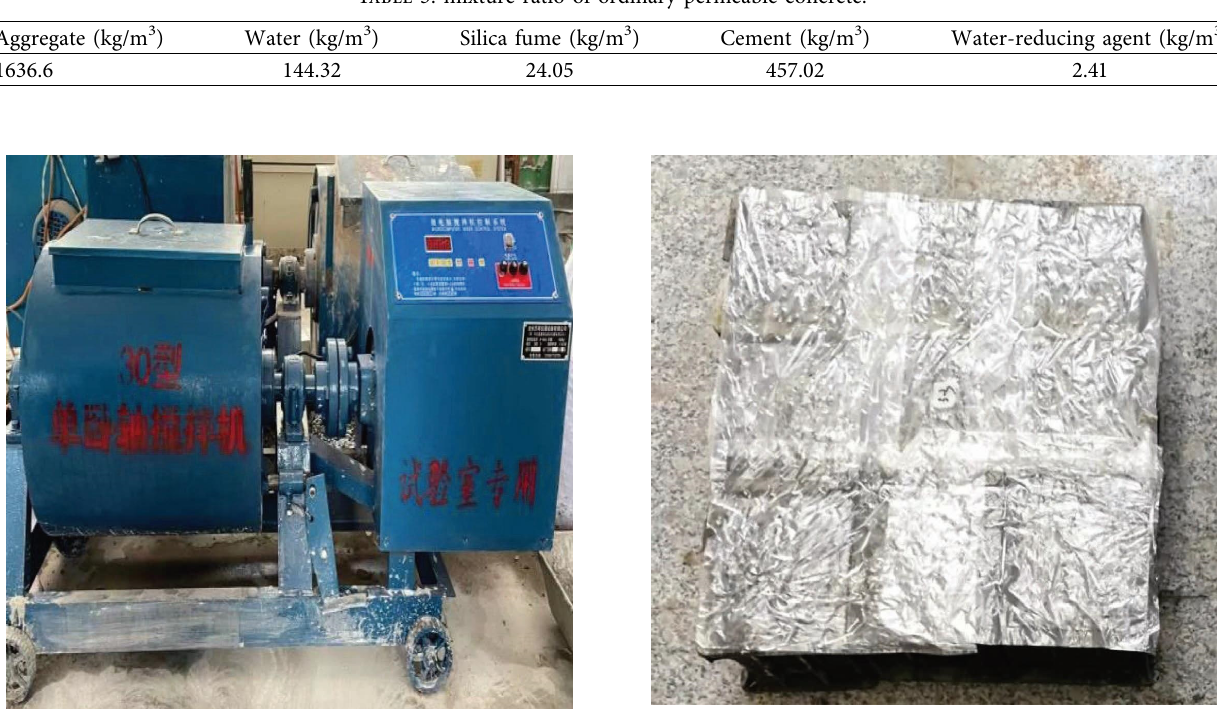
Figure 5: Sprinkling maintenance diagram of the cover flm of the test piece.